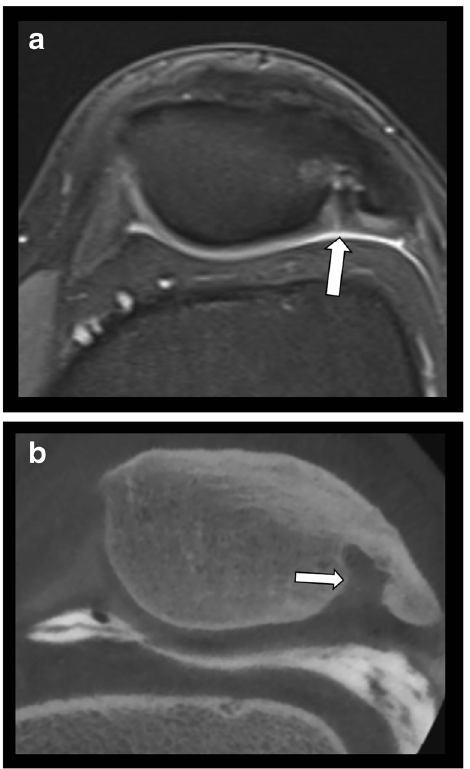
Fig. 13 Dorsal defect of the patella simulating a large cartilage defect on MRI. a . Axial T2 WI fat saturated MR image shows a focal bony defect with surrounding bone marrow edema at the superolateral aspect of the patella. There is suspicion of an overlying cartilage fissure (arrow). b . Axial reformatted CBCT-A demonstrates a dorsal patella defect. The overlying patellar cartilage is intact.